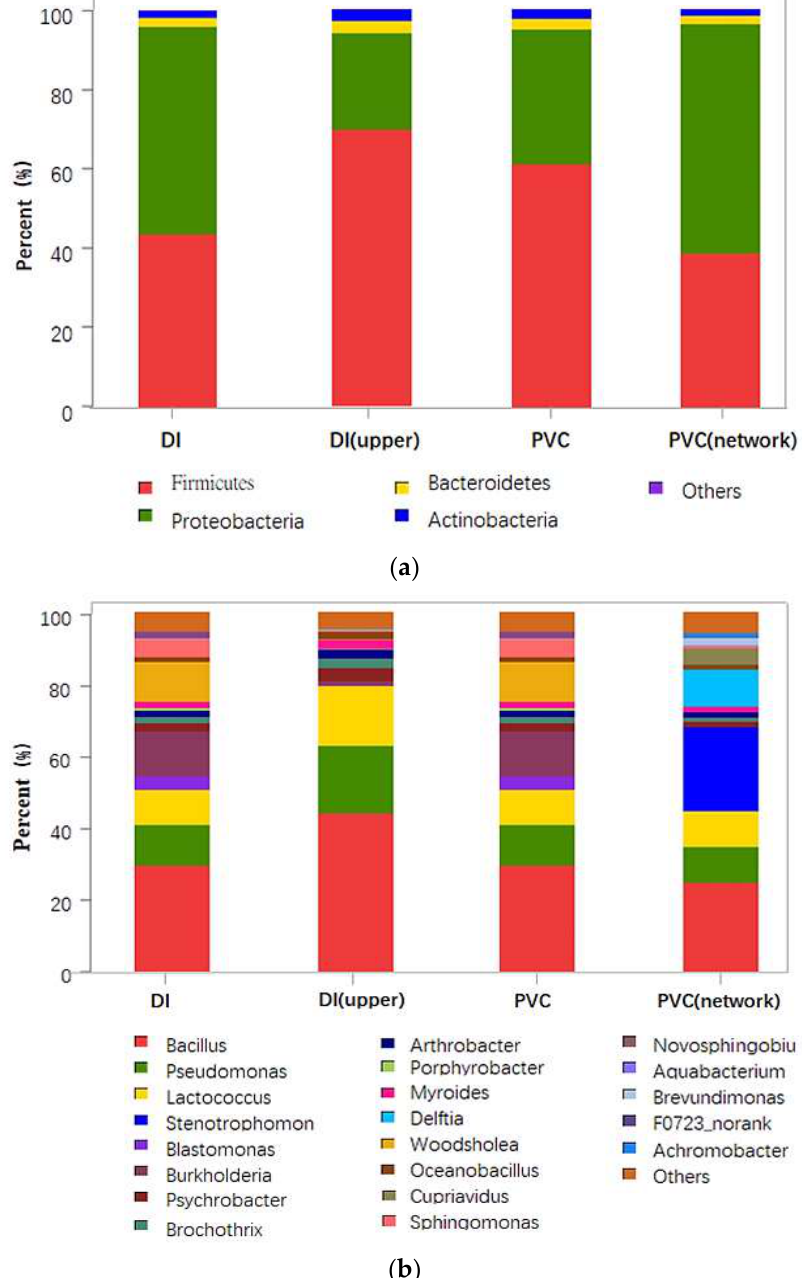
Figure 2. Relative abundance of different bacteria in different pipe materials: ( a ) At the phylum level; ( b ) At the genus level (n = 3).